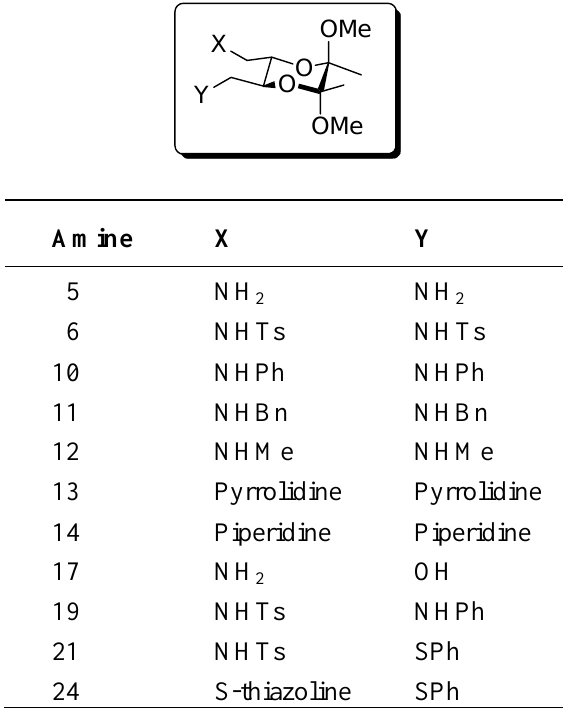
Table 2. Summary of chiral amines